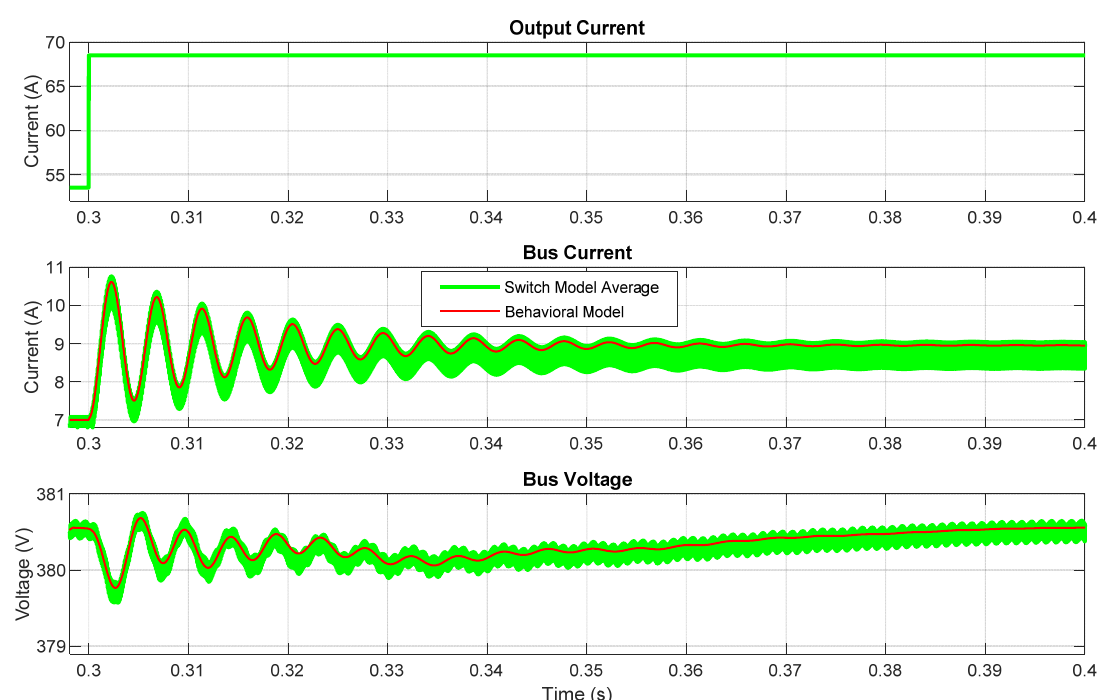
Figure 10. Bus current and bus voltage waveforms comparison for step change in output current. For the dc–dc buck converter, the roots are 1 × 10 3 ( − 1.0639 ± 0.88 i ) , i.e.,